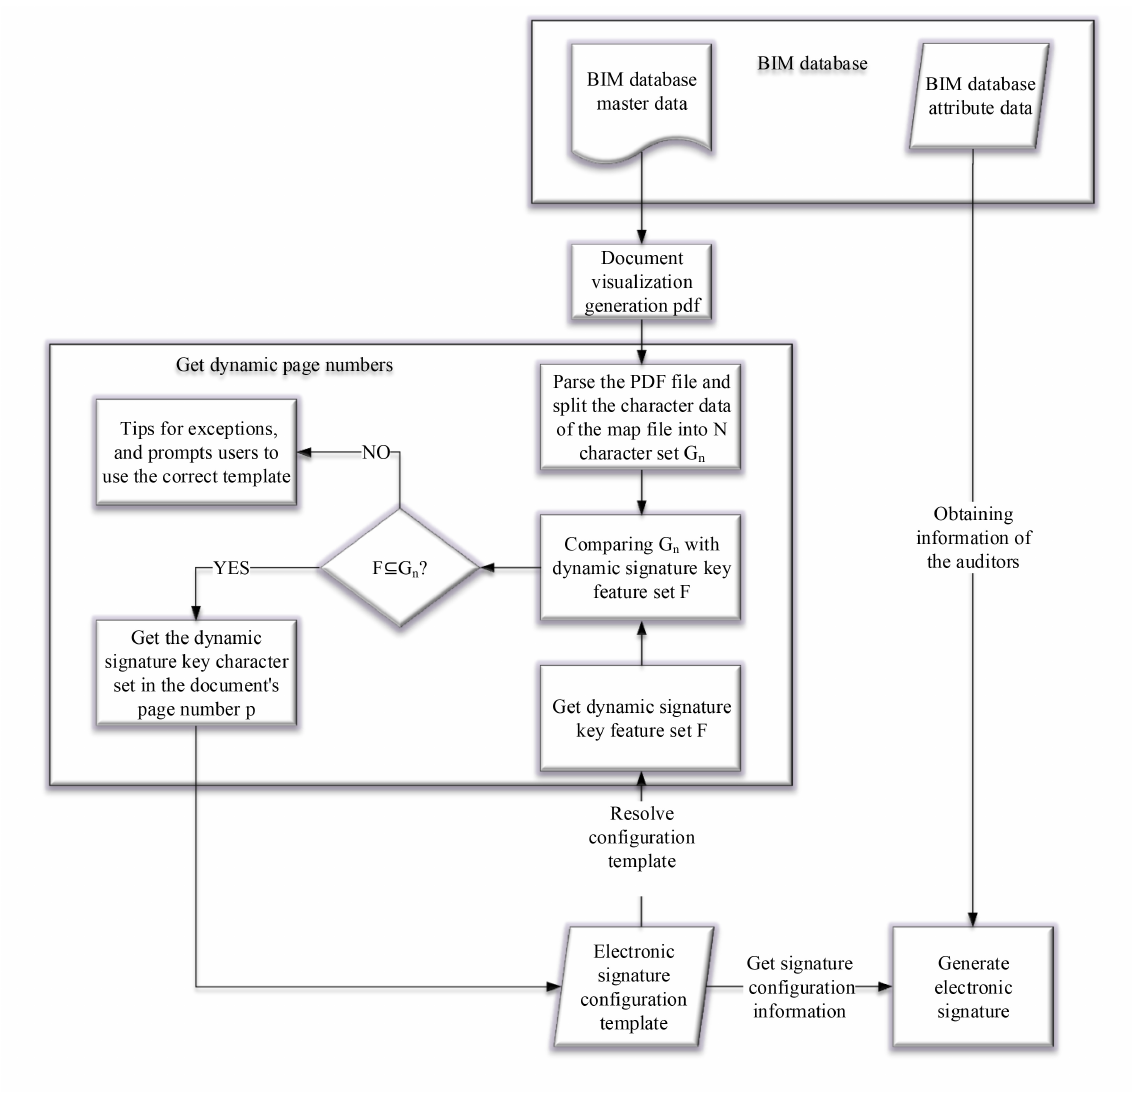
Figure 2. Dynamic signature